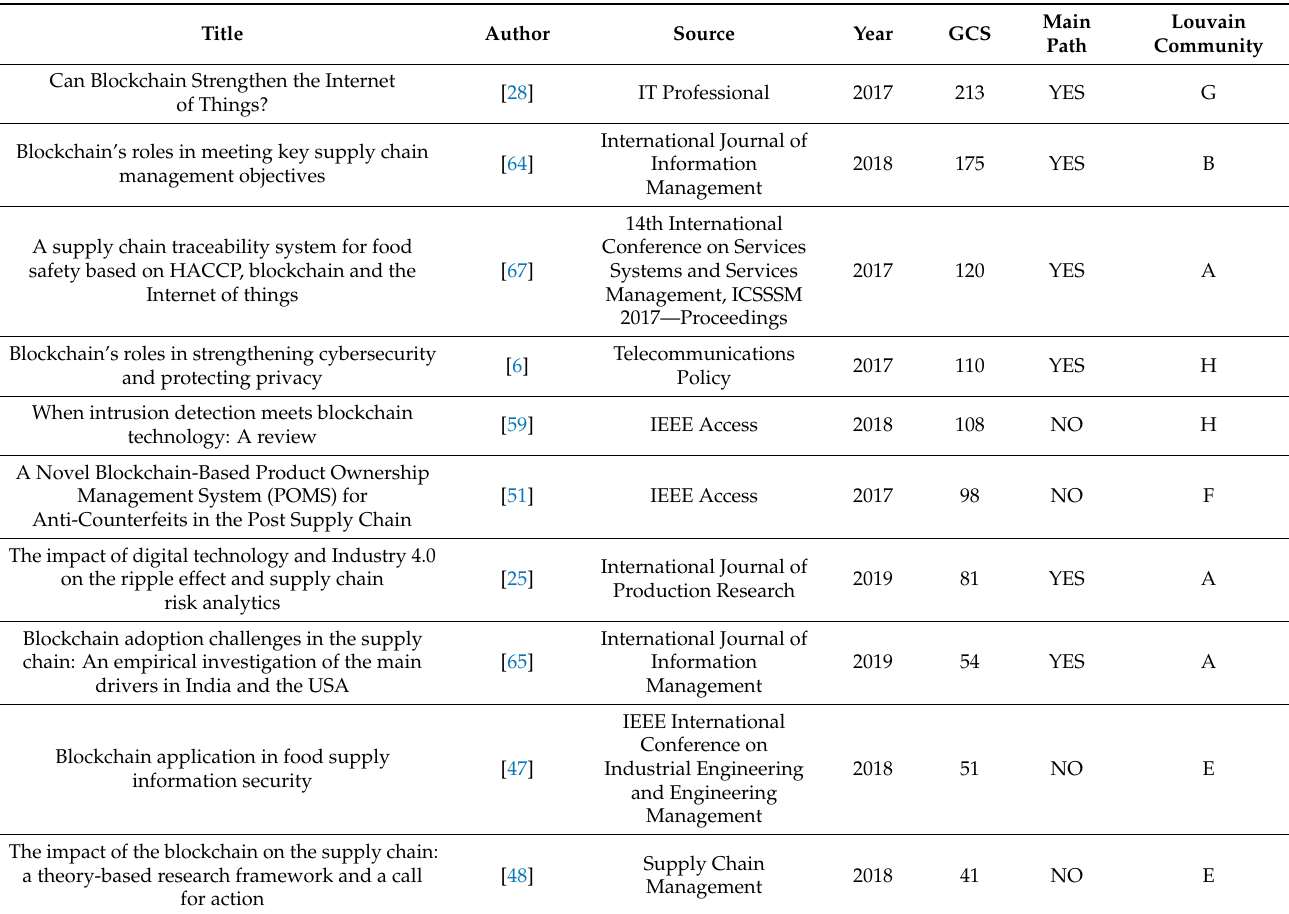
Table 2. Global citation score analysis (GCS) of the 10 most cited